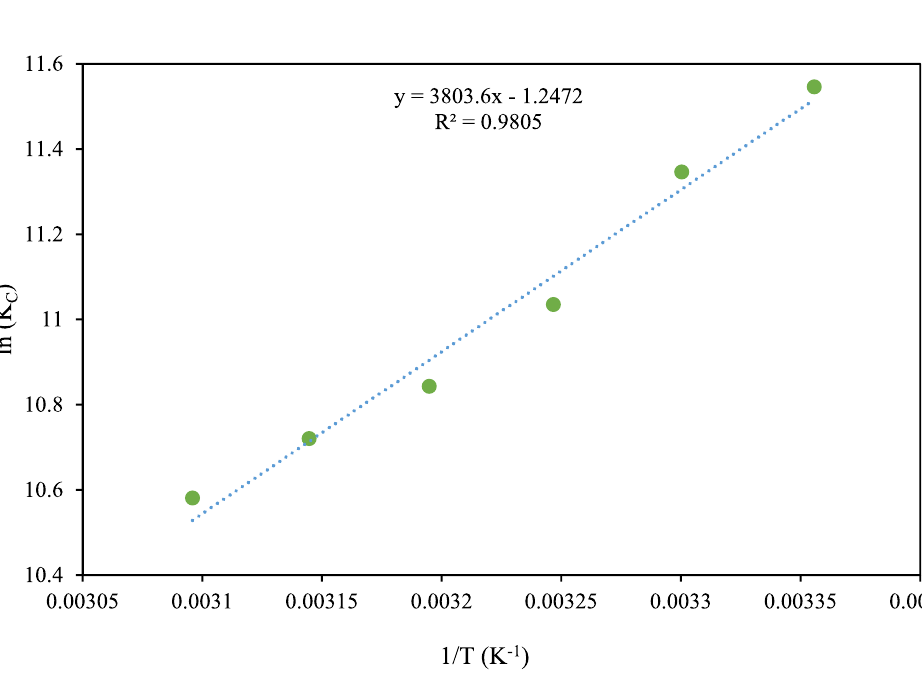
Figure 11. A thermodynamic model for RR 198 adsorption by MSW compost